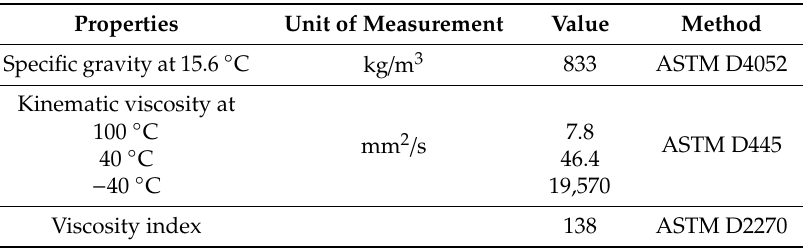
Table 1. Properties of PAO8.